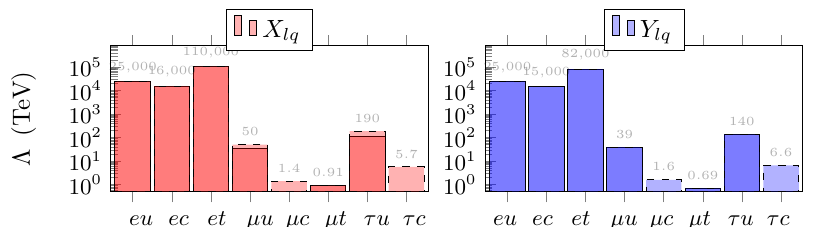
Figure 4 . The (cid:12)gure summarizes the most stringent constraints on the scale of R 2 and S 1 lepto- quarks, assuming X lq = 1 = (cid:3) 2 and Y lq = 1 = (cid:3) 2 , in the left and right panels, respectively. The dashed bars show the constraints obtained using the ‘central’ strategy while the solid bars indicate those obtained in the ‘R-(cid:12)t’ approach. The limit on the scale for the X (cid:28)t and Y (cid:28)t couplings are weaker than the range of (cid:3) shown in the